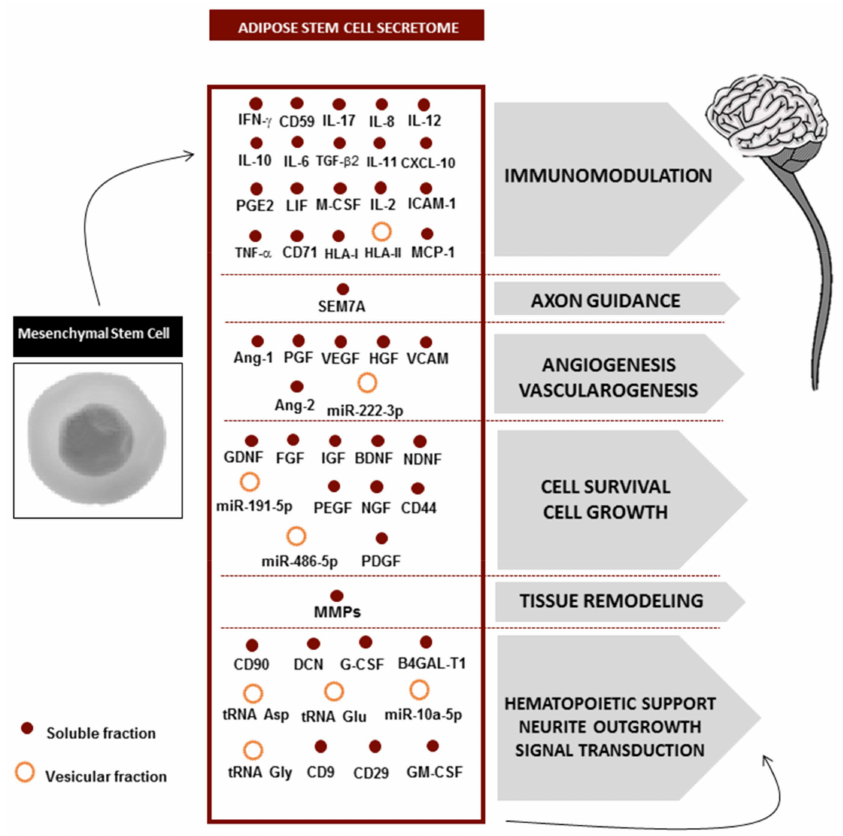
Figure 2. Mesenchymal stem cell secretome composition and their main e ff ects on the CNS. On their soluble fraction (red circles), MSC secretome contains cytokines, chemokines, growth factors, and glycoproteins. On their vesicular fractions (orange circles), the exosomes and microvesicles contain essentially microRNAs. Both the soluble and the vesicular fractions may act on distinct damaged cells of thenervoussystem, promotingtheirsurvival, angiogenesis, neuriteoutgrowth, andimmunomodulation. This information is based on the articles